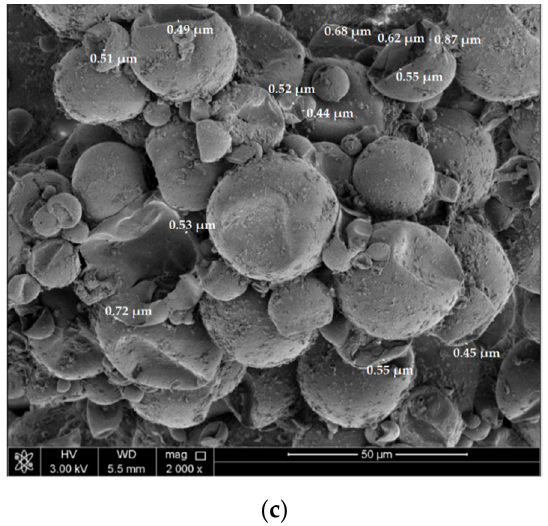
Figure 3. Microcapsule scanning electron microscope images at different scales: ( a ) 20 µm, ( b ) 40 µm, and ( c ) 50 µm.